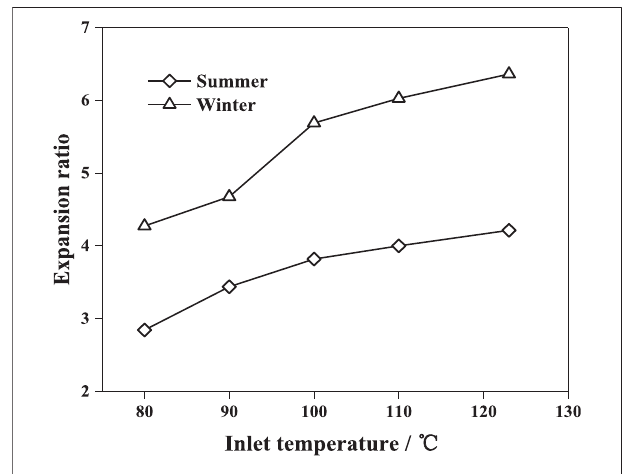
FIGURE 6 | The variation of the expander ratio with inlet temperature.